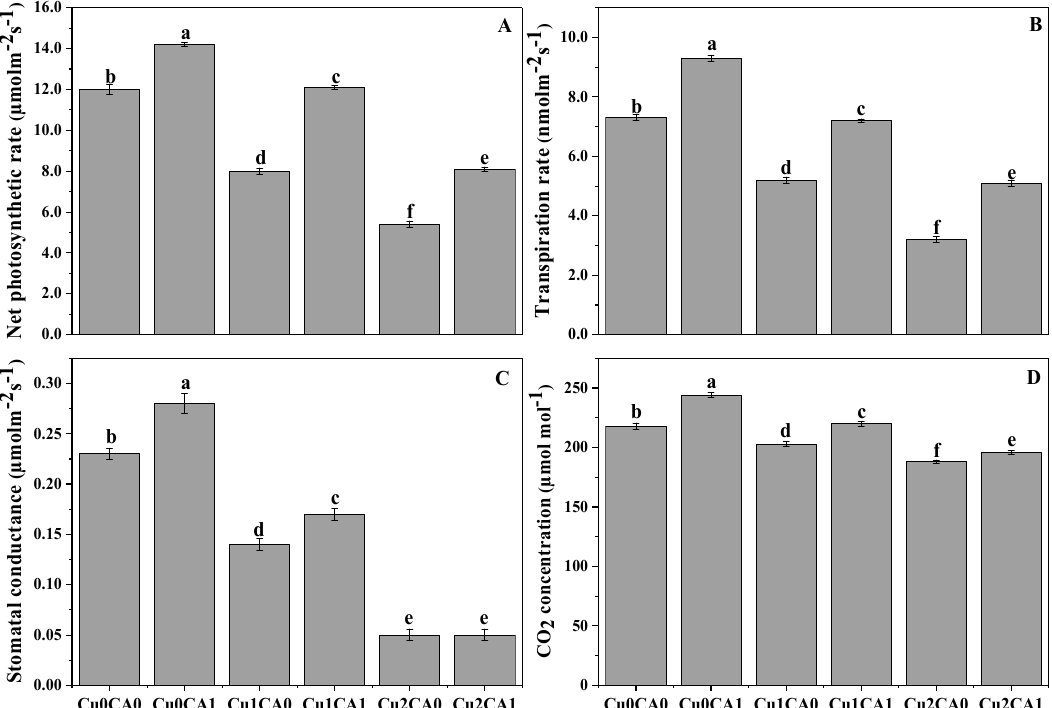
Figure 1. Effect of CA application on net photosynthesis (A), transpiration rate (B), stomatal conductance (C) and intercellular CO 2 concentration (D) in the leaves of C. capsularis seedlings grown under different stress levels of Cu. Values are demonstrated as means of three replicates along with standard deviation (SD; n = 3). One-way ANOVA was performed and means differences were tested by LSD ( p < 0.05). Different lowercase letters on the error bars indicate significant difference between the treatments. Cu 0 CA 0 (Cu = 0 μ M and CA = 0 mM), Cu 0 CA 1 (Cu = 0 μ M and CA = 2 mM), Cu 1 CA 0 (Cu = 50 μ M and CA = 0 mM), Cu 1 CA 1 (Cu = 50 μ M and CA = 2 mM), Cu 2 CA 0 (Cu = 100 μ M and CA = 0 mM), Cu 2 CA 1 (Cu = 100 μ M and CA = 2 mM).